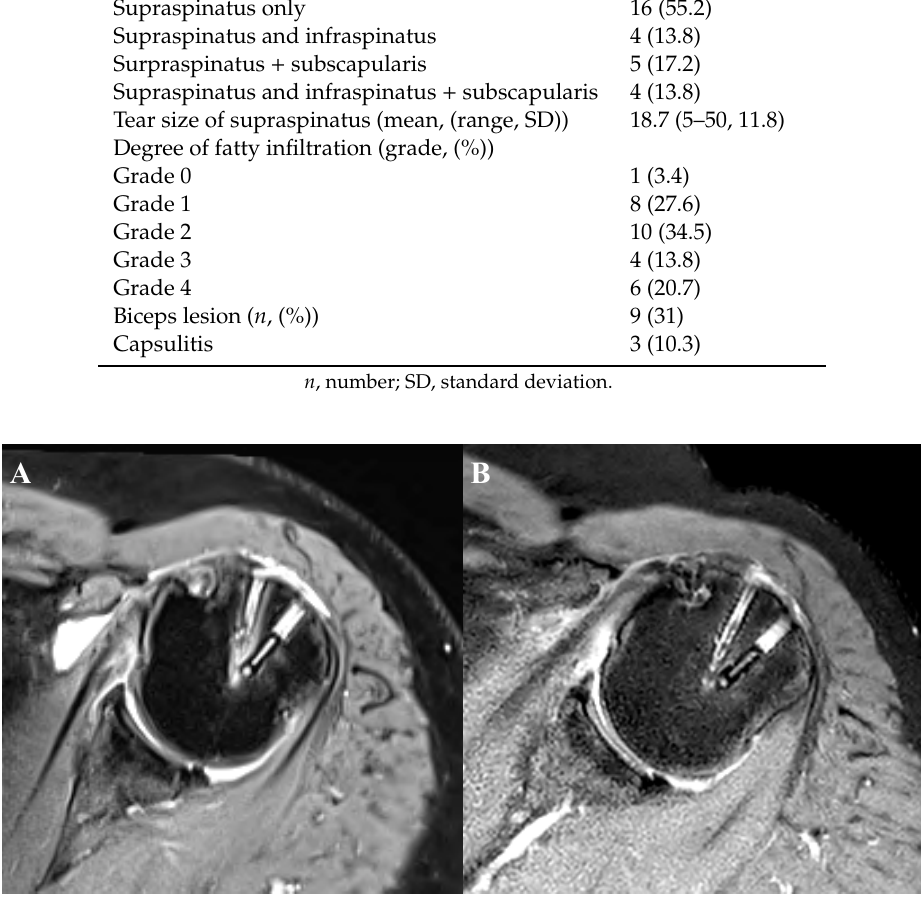
Figure 2. A 74-year-old woman with full-thickness supraspinatus tear underwent arthroscopic rotator